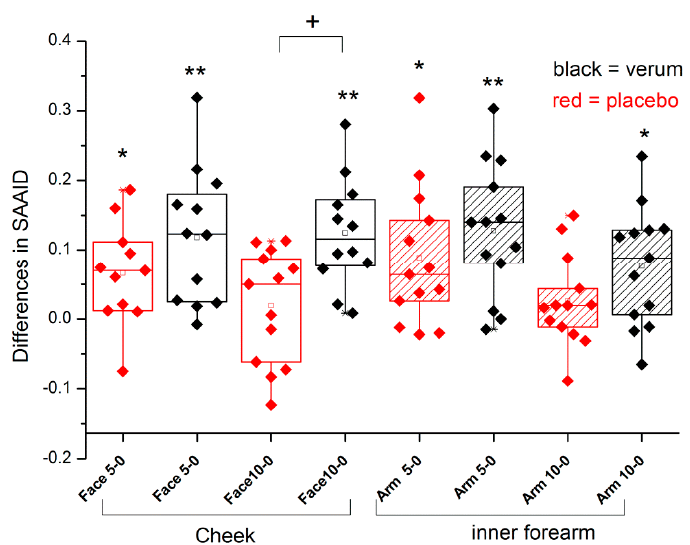
Figure 2. Box plot of the differences of SAAID to the initial values measured at the cheek and inner forearm. + p < 0.05 between placebo and verum; * p < 0.05, ** p < 0.01 to initial value. The box presents 50% of the data. The bottom and top of the box are always the first and third quartiles and the solid line box is always the second quartile, the median.